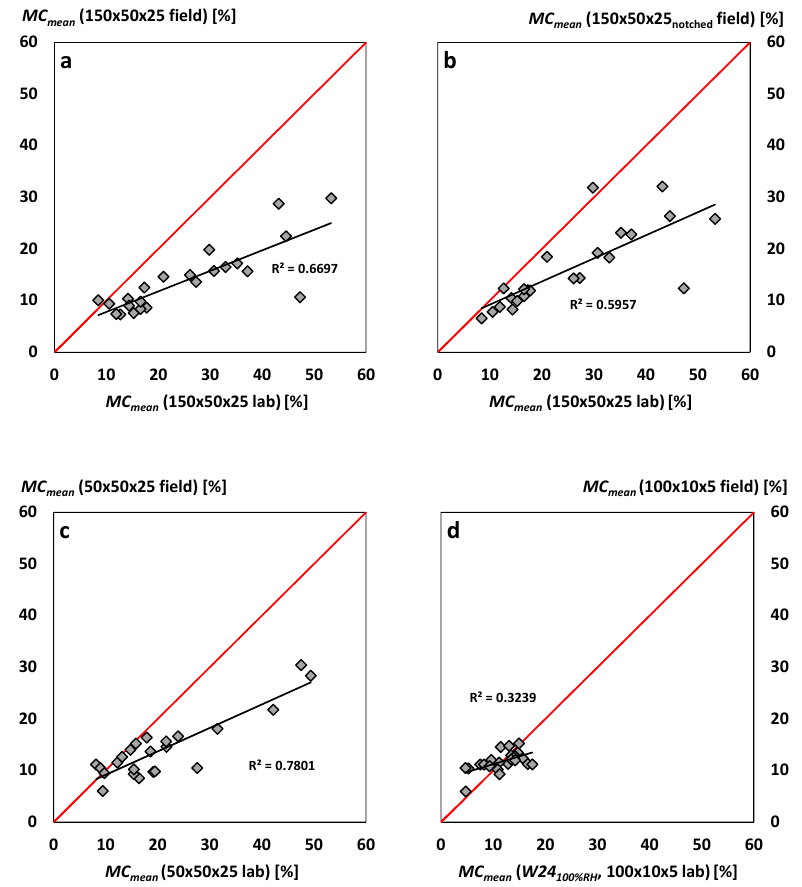
Figure 11. Interrelationship between MC mean (%) measured during outside exposure and MC mean (%) measured in laboratory submersion ( a , b ), floating ( c ) and 24 h water uptake and release tests ( d ).